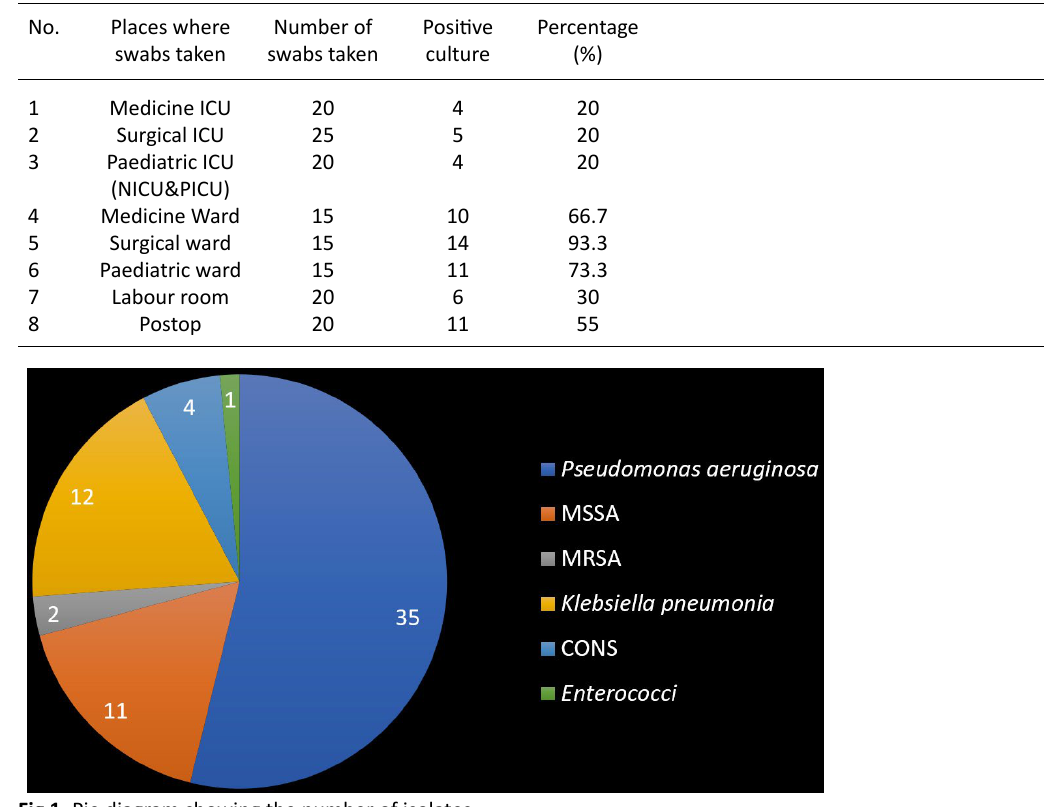
Fig 1. Pie diagram showing the number of